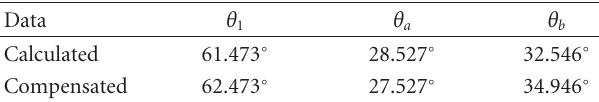
Table 2: Photovoltaic performance of DSSC with and without EL. DSSC J sc (mA/cm 2 ) V oc (V) FF η (%) Without EL 6.90 0.685 0.591 2.79 With one EL 8.04 0.676 0.581 3.16 With two ELs 9.53